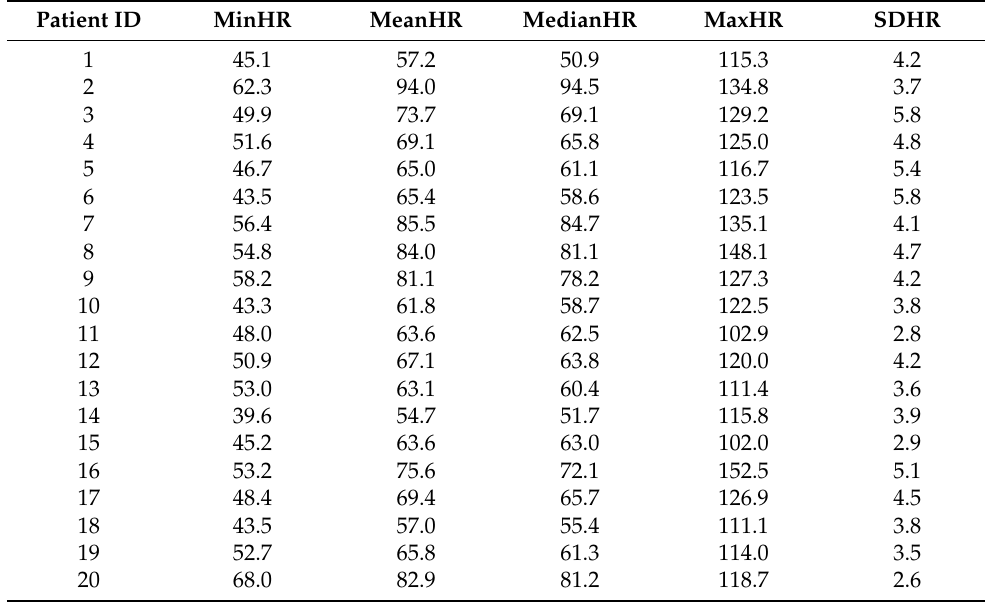
Table A8. Mean Fitbit heart rate over the entire Fitbit observation time (27